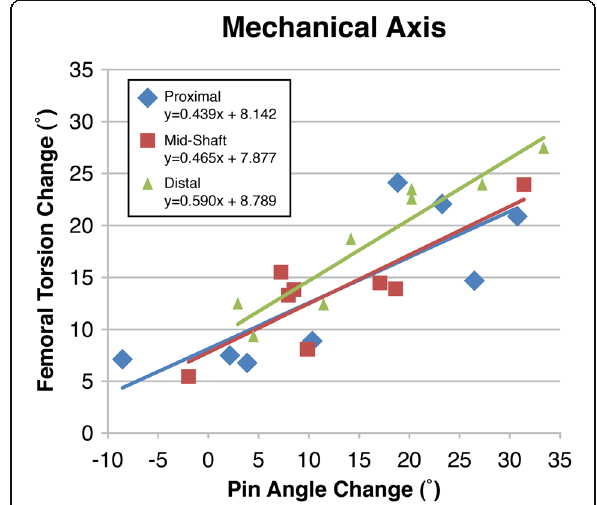
Fig. 4 Change in femoral torsion in the mechanical axis with pin angle, rotation through the osteotomy, change. All correlations are significant